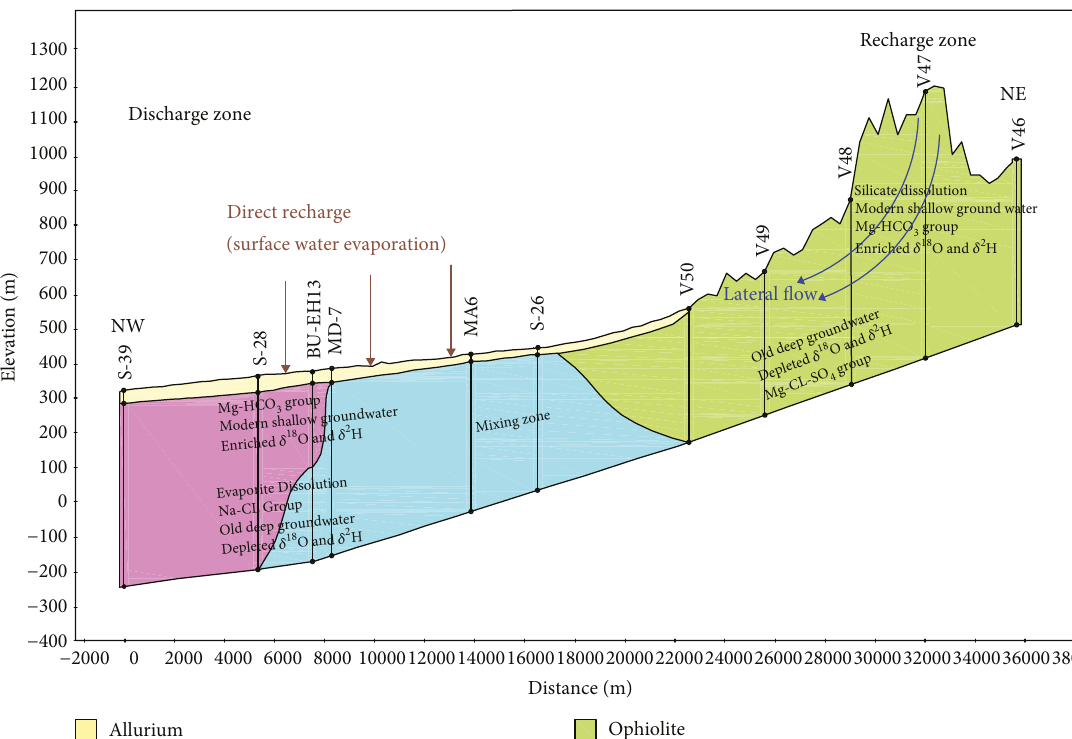
Figure 10: Hydrogeological/hydrogeochemical schematic cross section summarizes the groundwater chemistry and the prevailing physiochemical processes (see Figure 1 for the